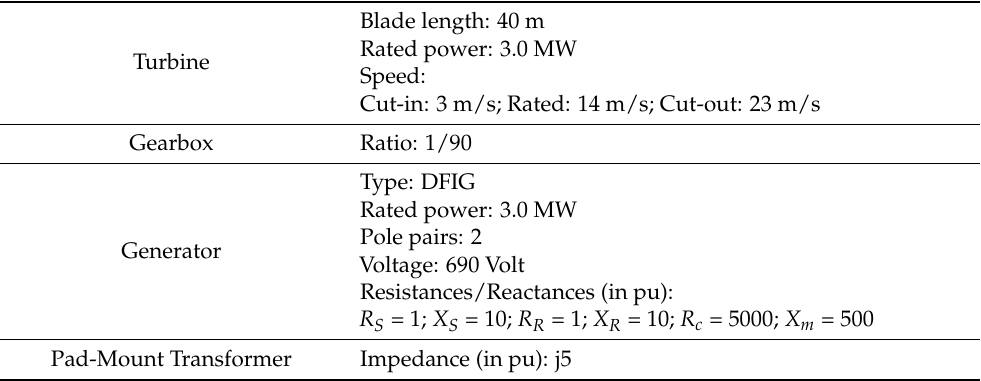
Table 4. WTG unit